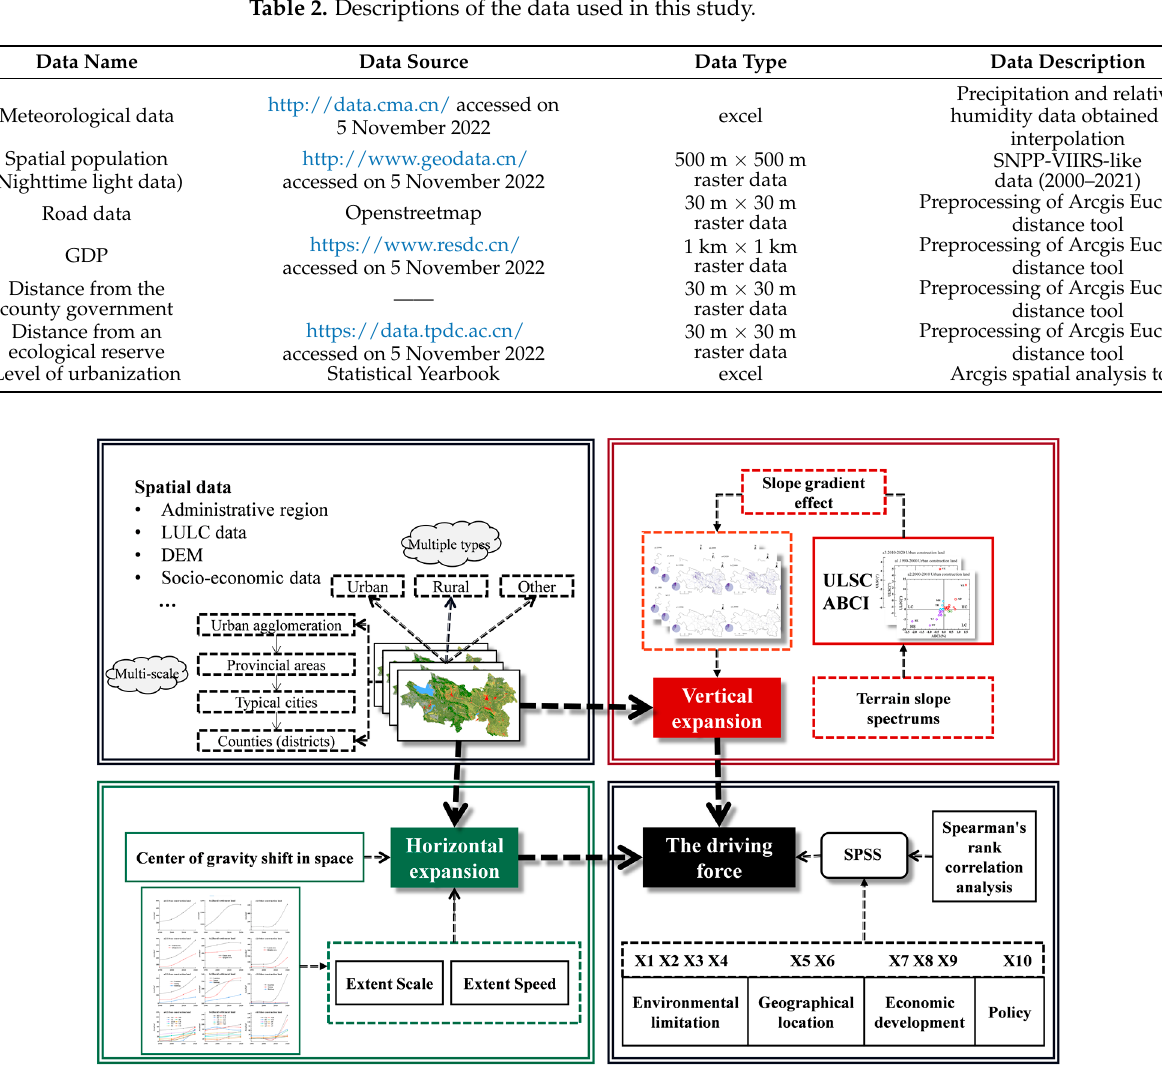
Figure 2. General research